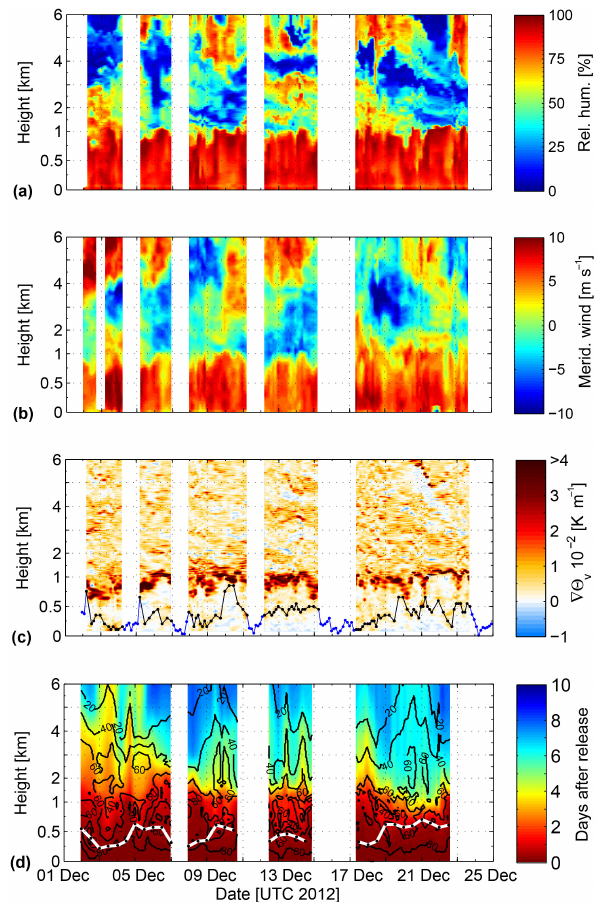
Figure 4. (a–c) Radiosonde observations of the lower 6km of the atmosphere between 2 and 24 December 2012 on R/V METEOR . Shown are (a) the relative humidity in %, (b) the meridional wind in ms − 1 and (c) the gradient of the virtual potential temperature in 10 − 2 Km − 1 in combination with the determined MABL height (black) and the associated MABL height above the oceanic up- welling from the multiple linear regressions (blue). (d) Distribution of 10-day FLEXPART forward trajectories. The black contour lines give the amount of trajectories in percentage reaching an altitude of 0–6km height within the 10 days. The elapsed time in days until these trajectories reach this height is reflected by the colour shading. The white line shows the ERA-Interim MABL height at the ship’s position. Trajectory analyses gaps close to the coast are whitened (Sect. 2.4). The y axes are